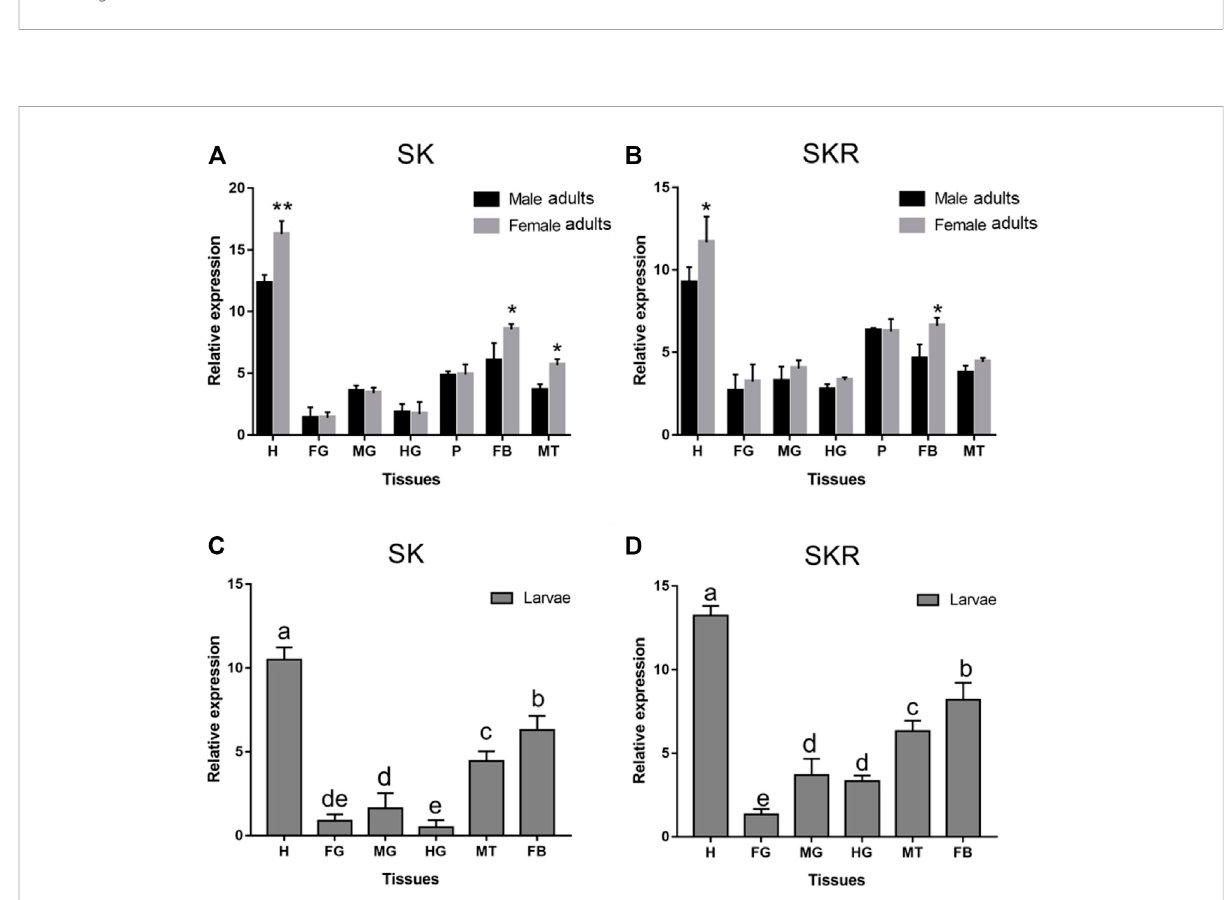
FIGURE 4 Relative expression levels of SK (A) and SKR (B) in emerged adults and SK (C) and SKR (D) in larvae in the different tissues of D. armandi . The relative expression levels were normalized with β -actin and CYP4G55 . Different lowercase letters indicate signi fi cant differences at the 0.05 level. The asterisk indicates asigni fi cant difference between female and male expression levels (* p < 0.05 and ** p < 0.01, independentStudent ’ st-test).All values are mean ± SE , n = 3. H, head; FG, foregut; MG, midgut; HG, hindgut; P, pheromone gland; MT, Malpighian tubules; FB, fat